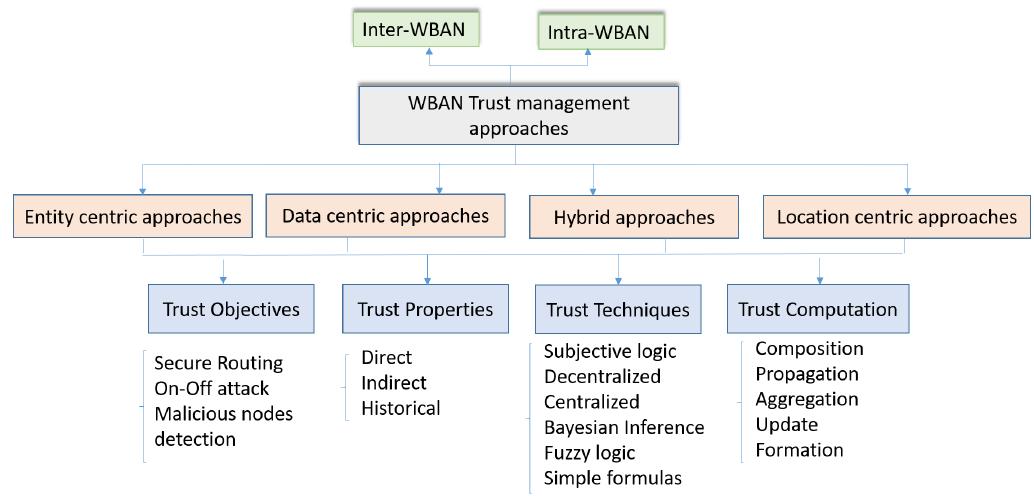
Figure 6. New classification for trust management approaches in